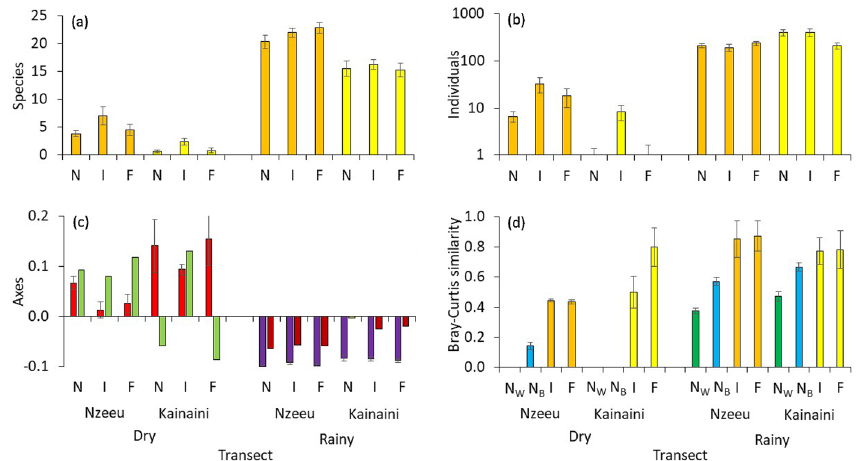
Figure 2. Species richness ( a ), and number of individuals ( b ), along the Nzeeu (orange) and Kainaini (yellow) rivers; given is the mean per transect. ( c ) Average scores of the dominant (explained variance: 91.5%; red: dry season, violet: rainy season) and subdominant (explained variance: 3.5%; green: dry season, brown: rainy season) PCoA eigenvectors across transects. ( d ) Bray–Curtis similarities of the intermediate (I) and far (F) transects to the near river transects (N), as well as average Bray–Curtis similarity within the eight near river transects N W (green bars; only calculated for the rainy season; data insufficient for dry season) and the average similarities across the eight near river transects N B (blue bars; data insufficient for Kainaini during the dry season). Error bars in ( a ), ( b ), and ( c ) denote standard errors from eight sample points in each transect. Error bars in ( d ) are based on 1000 bootstrap samples. Abbreviations: N—near river transects; I—transects at intermediate distance from river (i.e. 250 m); F—transects far from river (i.e. 500 m); N W —average Bray–Curtis similarity within the eight walks in the near river transects; N B —average similarities across the eight near